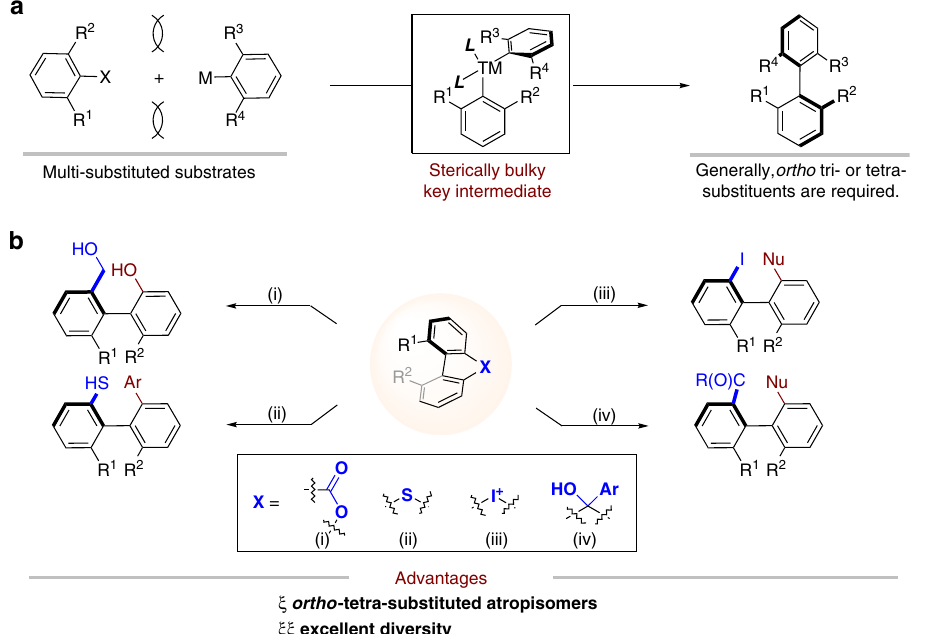
Fig. 1 Ring-opening strategies for atropisomer synthesis. a Asymmetric aryl – aryl cross-coupling. b Ring-opening strategy for the construction of axially chiral